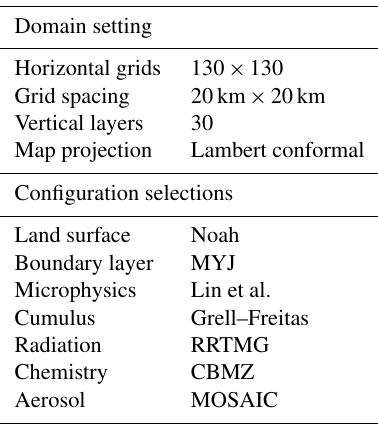
Table 1. WRF-Chem domain setting and configuration